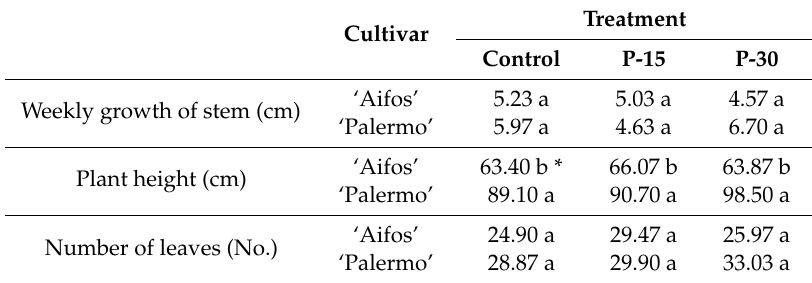
Table 1. E ff ect of fertilizer with polyphosphates in hydroponic cultivation on the height of pepper plant, number of leaves on the plant and weekly growth of stem depending on cultivar (average of two